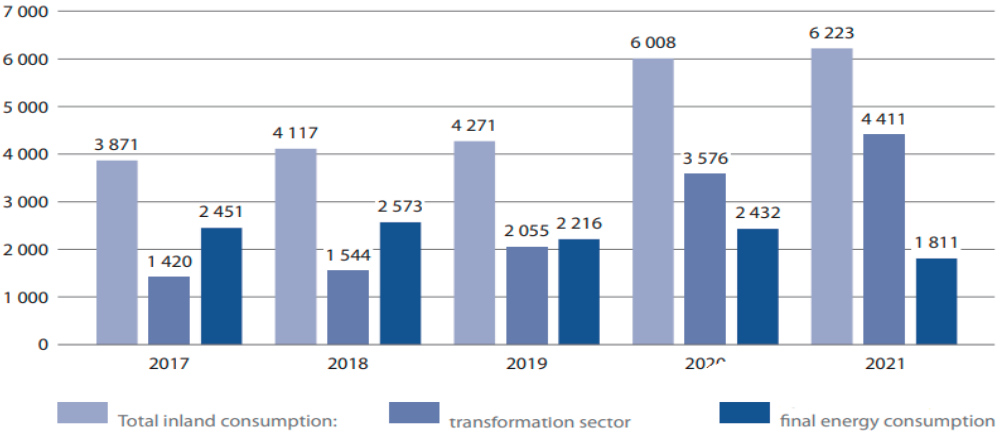
Figure 3. Consumption biodegradable municipal waste. Source: Renewable energy in 2021, CSO, Warsaw, 2022.